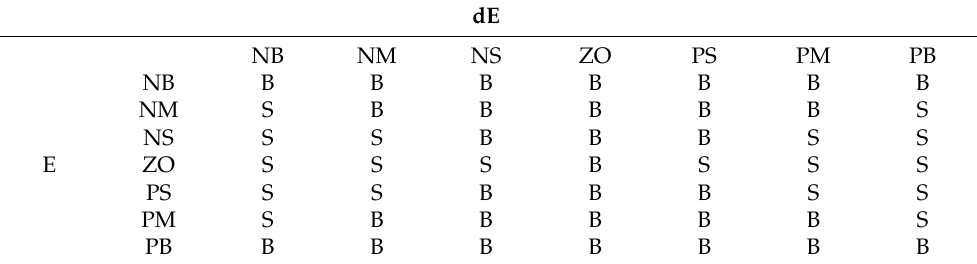
Table 2. Fuzzy tunning rules for K ′ d .